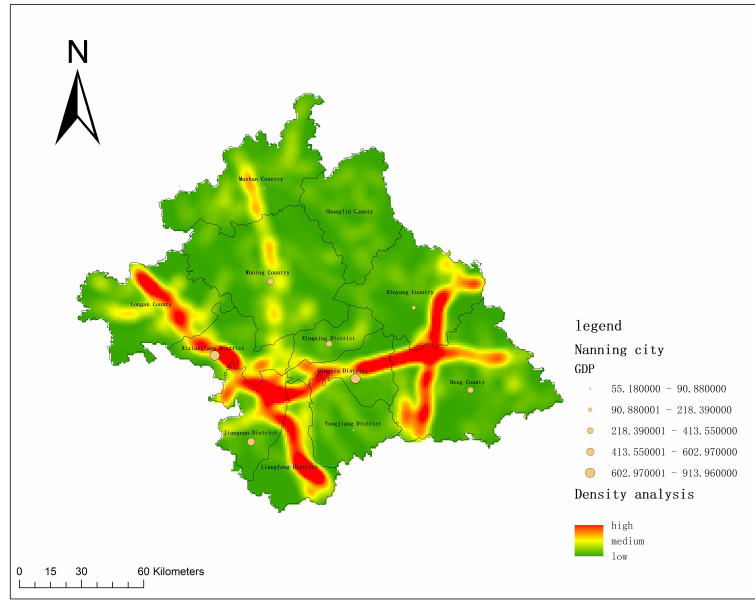
Figure 4. Analysis of road density in Nanning